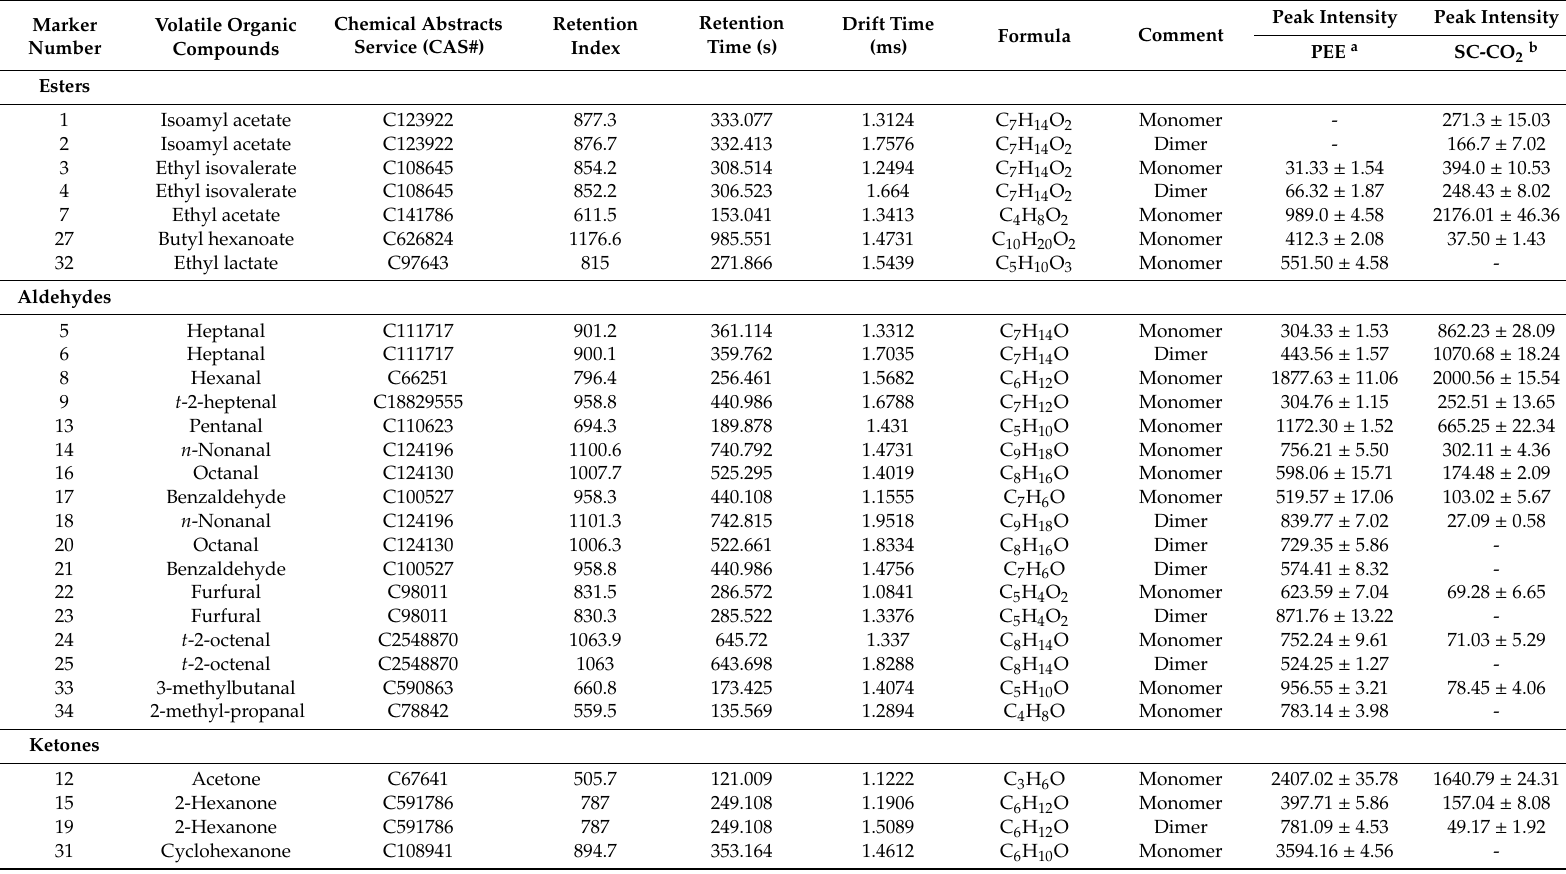
Table 6. Volatile organic compounds and content of B. dasystachya seed oil extracted by PEE and SC-CO 2